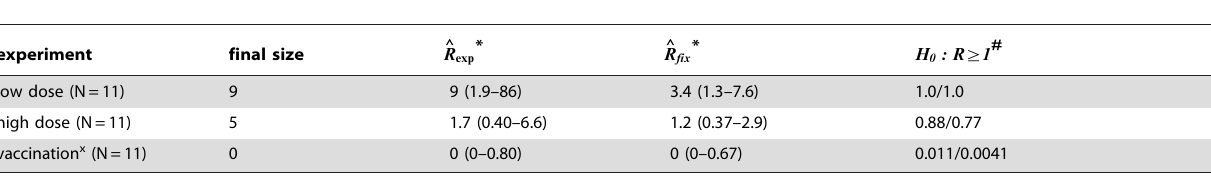
* maximum likelihood estimates of the reproduction number with 95% confidence intervals (between brackets) if the infectious period is exponentially distributed ( R or of fixed duration ( R fix ). # p-values of the null hypothesis under the assumption of an exponentially distributed and fixed infectious period. x all experiments with vaccinated birds (Table S1) yielded a final size of 0. Shown are the results for a single vaccination experiment. doi:10.1371/journal.ppat.1000281.t003 PLoS Pathogens |